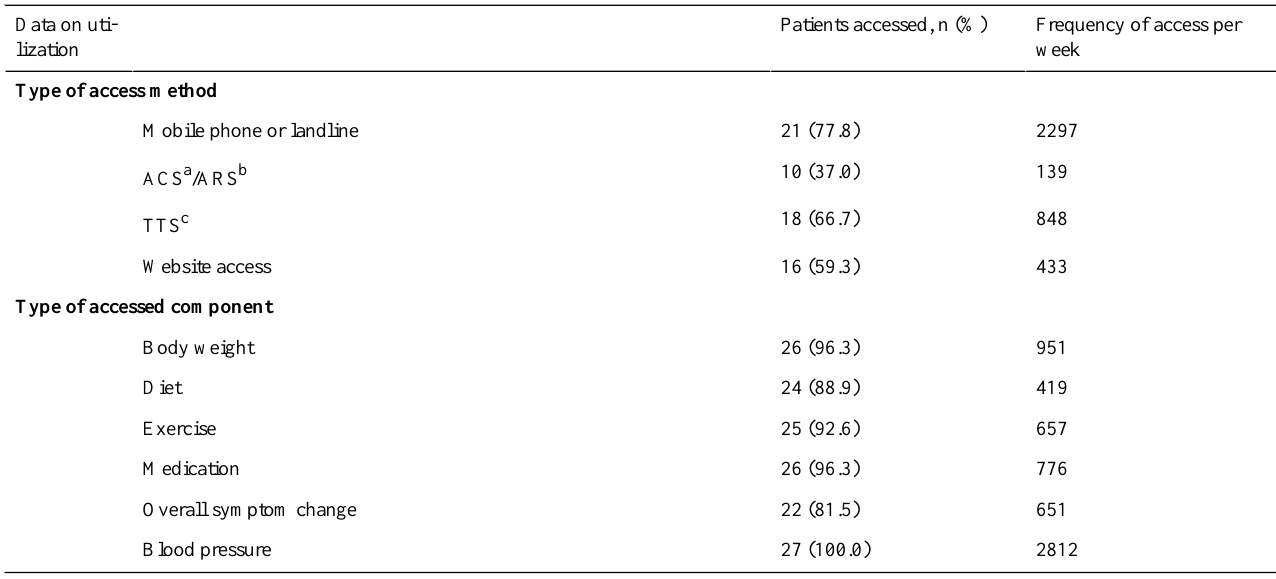
Table 2. Data on utilization of information communication technology (ICT)–based telehealth program in heart failure